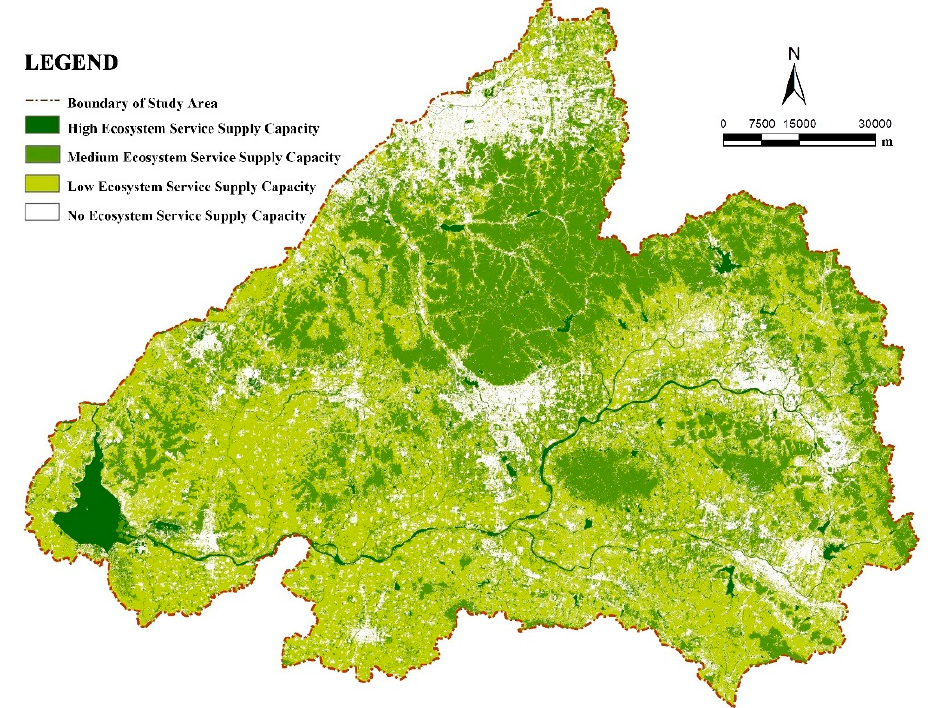
Figure 4. MSPA landscape types in Taishan area.